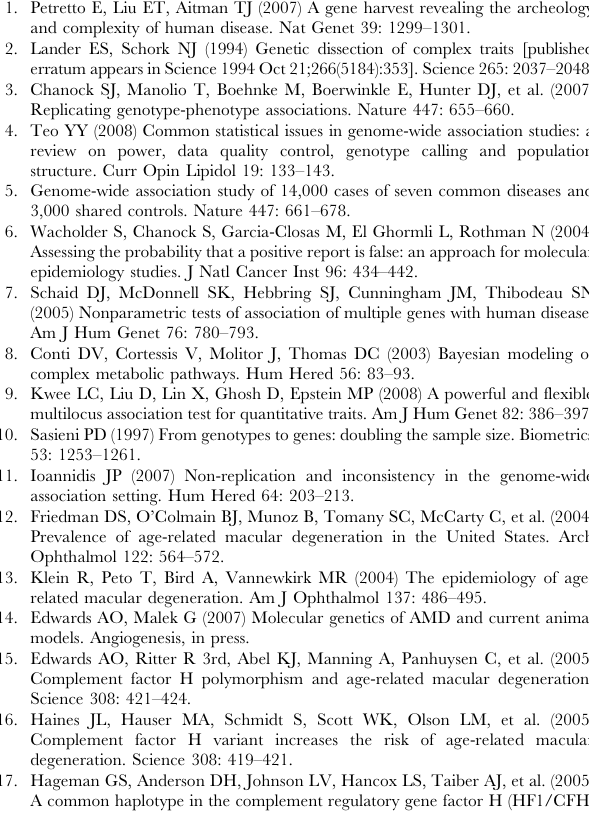
Table S2 Biological information and statistical tests of allele and genotype association with AMD in the AREDS subjects (dbGAP data) and Mayo subjects. The replicated SNP in C3 is highlighted.